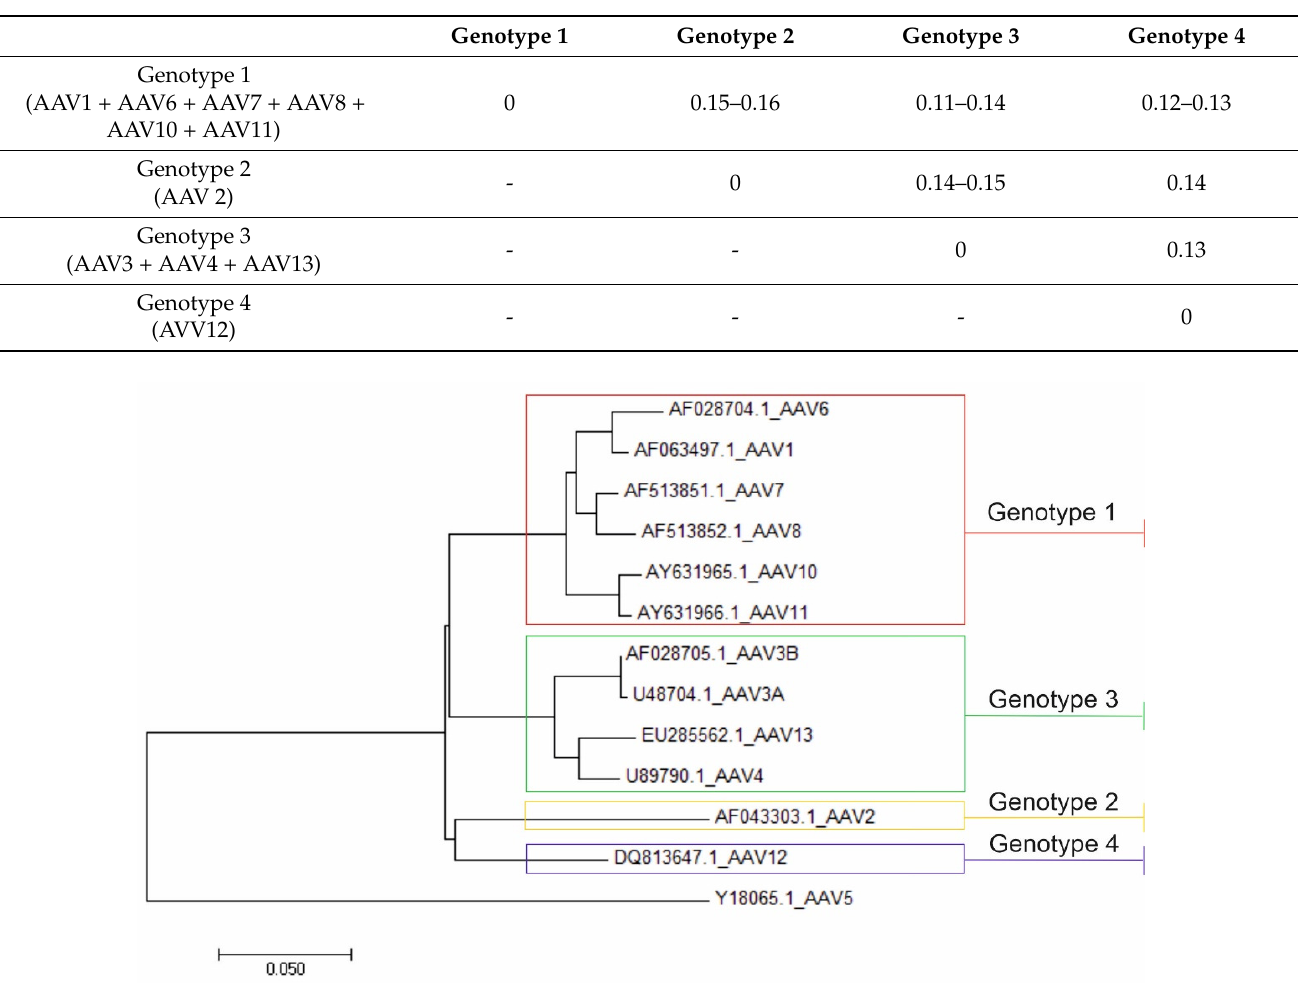
Table 2. Distinct AAV genotypes identified based on nucleotide sequence differences and the corresponding currently registered serotypes. The table shows the range of the proportions of different nucleotides between the respective genotypes.